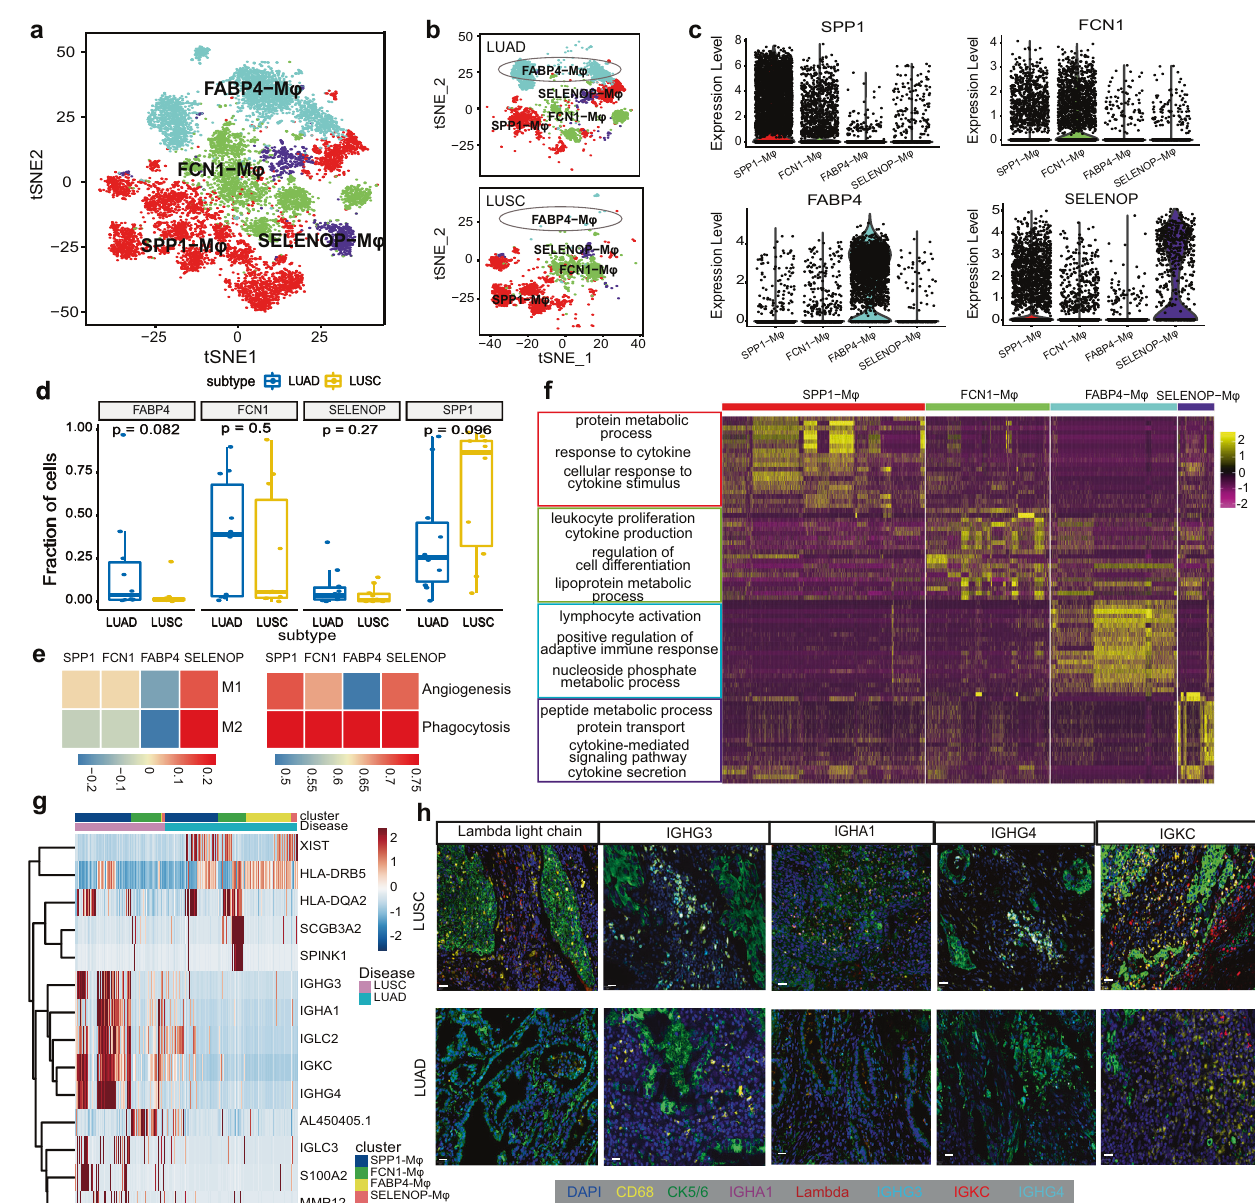
Fig. 5 Re-clustering and gene expression patterns of M φ in LUAD and LUSC. a Clustering of 11,016 M φ s from all samples. Each dot corresponds to a single cell, colored according to cell type. b t-SNE of M φ subtype in LUAD (top) and LUSC (bottom). c Violin plots of speci fi c marker genes in each M φ subcluster. d Box plot showing the differential expression of FABP4 , FCN1 , SPP1, and SELENOP in LUAD and LUSC. The P values by Wilcoxon tests are shown. e Differences in functional activities scored each M φ subtype by ssGSEA based on the marker genes of M1, M2, angiogenesis and phagocytosis. f Heatmap of speci fi c differentially expressed genes of each M φ subtype and the GO annotation of these genes. g Heat map showing the different tumor-related molecules in various M φ subtypes between LUAD and LUSC. h Multicolor IHC staining for verifying the high expression of antibody transcripts in M φ from LUSC compared with LUAD. The scale bar represents 20 μ m Single-cell regulatory network inference and clustering (SCENIC) tumor angiogenesis molecules of CXCL8 and VEGFA , and the analysis was performed to assess the differences in the expression myeloid suppression cell molecules of THBS1 and IL1B (Fig. 6e, f), levels of transcription factors (TFs) in the process of M φ while in LUAD, some chemokine-related molecules, including differentiation. 24 The number of TF target genes is listed in CCR2, CCL2, and FPR2 , were increased as well as the T-cell activation factor CD44 and the T cell activation inhibitor ANXA1 Supplementary Table 7. PPI network analysis in branch 1 and were highly expressed during the developmental trajectory (Fig. branch 2 revealed that the TF target genes enriched in branch 1 6c, e, f). Taken together, these results suggested that the were CXCL2 , CCL3 , SPP1, and ICAM1 , while those enriched in differentiation trajectory of M φ conducted multiple immune branch 2 included TNFRSF1B , TNFSF13B , and VEGFA (Fig. 6g, h). functions in the progression of both NSCLC subtypes, but was Upon further analysis, although LUAD and LUSC shared TFs, they more evident in LUSC. also exhibited exclusive TFs (Supplementary Fig. 7c). For instance,